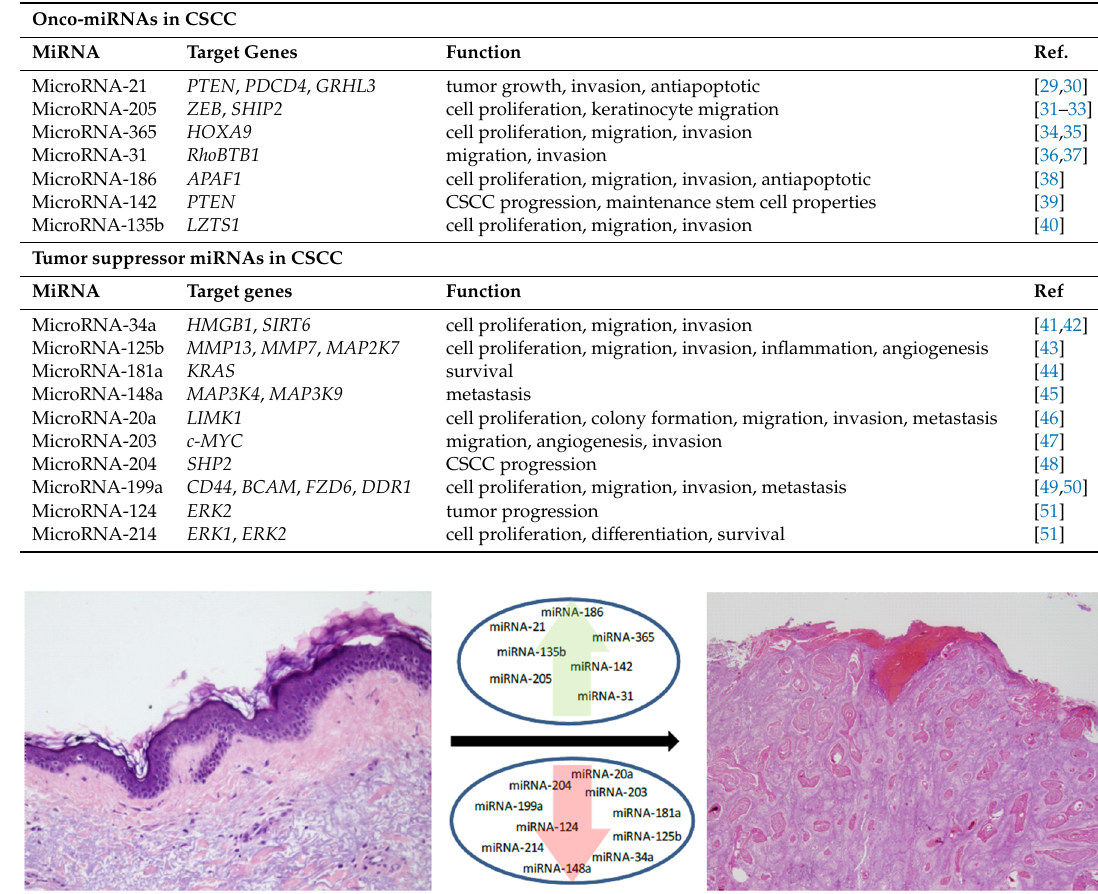
Table 1. MicroRNAs (MiRNAs) implicated in cutaneous squamous cell carcinoma and their functions. Panel A (onco-miRNAs) and Panel B (tumor suppressor miRNAs).